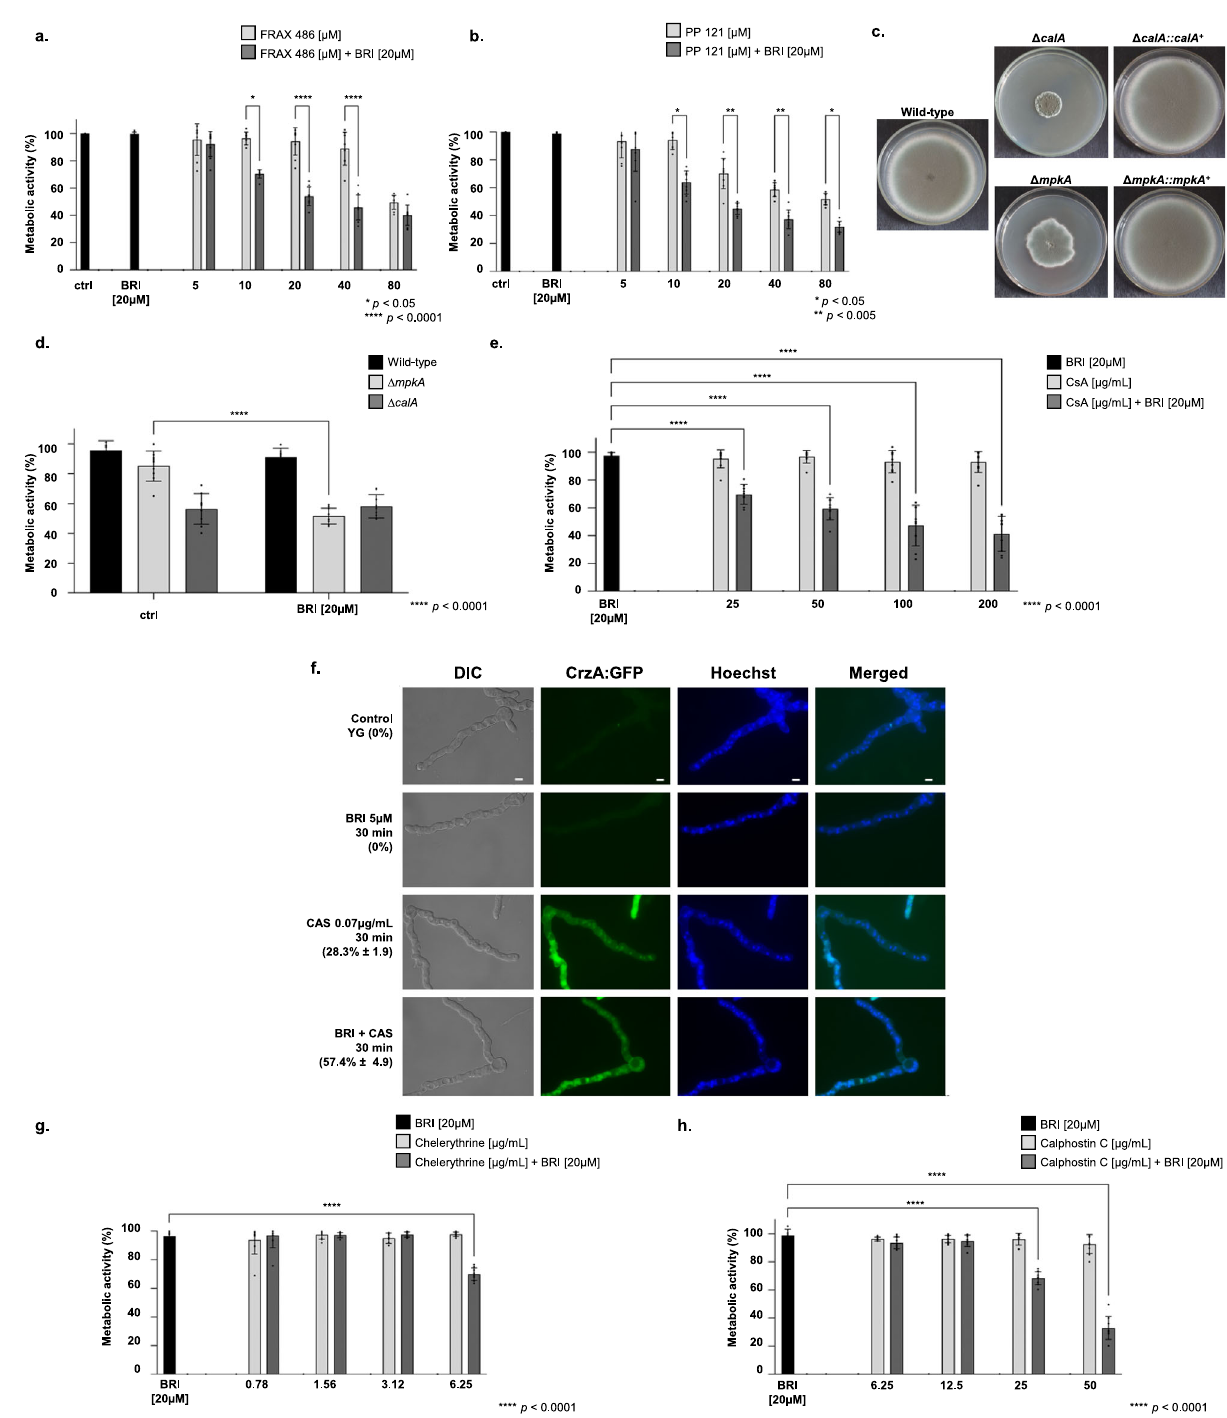
Fig. 3 | Calcineurin and the MAPK MpkA are important for the BRI+CAS synergism.a MetabolicactivityexpressedbyAlamarblueof A.fumigatus grownfor 48h in the absence or presence of BRI [20 µ M],FRAX486 [5 – 80 µ M] orBRI [20 µ M] + FRAX486 [5 to 80 µ M]. b Metabolic activity expressed by Alamar blue of A. fumigatus grown for 48h in the absence or presence of BRI [20 µ M], PP121 [5 to 80 µ M] or BRI [20 µ M] + PP121 [5 to 80 µ M]. c Growth of the wild-type, Δ calA , Δ calA::calA + , Δ mpkA , and Δ mpkA::mpkA + on MM for 5days at 37°C. d Metabolic activity expressed by Alamar blue of A. fumigatus wild-type, Δ calA , and Δ mpkA grown for 48h in the absence or presence of BRI [20 µ M]. e Metabolic activity expressedbyAlamarblueof A.fumigatus grownfor48hintheabsenceorpresence of BRI [20 µ M], cyclosporin (CsA) [25 to 200 µ g/mL] or BRI [20 µ M] + CsA [25 to 200 µ g/mL]. f CrzA:GFPtranslocationtothenucleuswhengermlingswereexposed